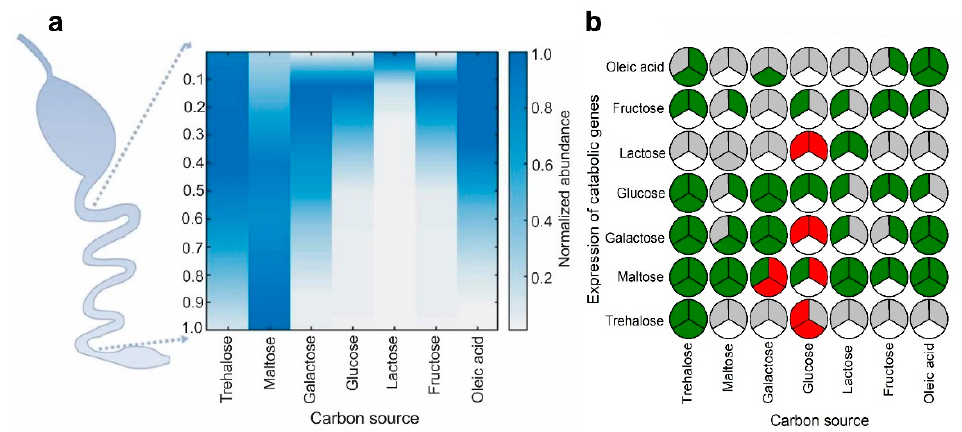
Figure 2. ( a ) The spatial abundance of different carbon sources in the intestine; ( b ) Expected and validated cross-regulation in the intestine. Top left slice, regulation based on the expectation and published knowledge; top right slice, regulation denoted from the RNA-Seq; bottom slice, regulation verified by the RT-PCR. Green, positive regulation; red, negative regulation; grey, no regulation; white, not measured.